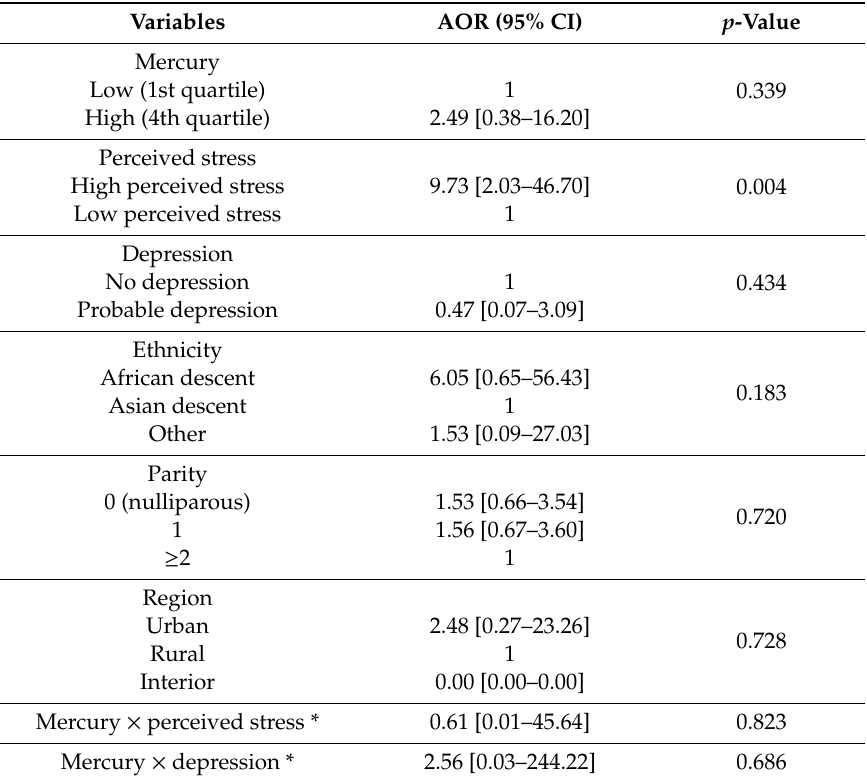
Table 6. Multivariable model for low Apgar